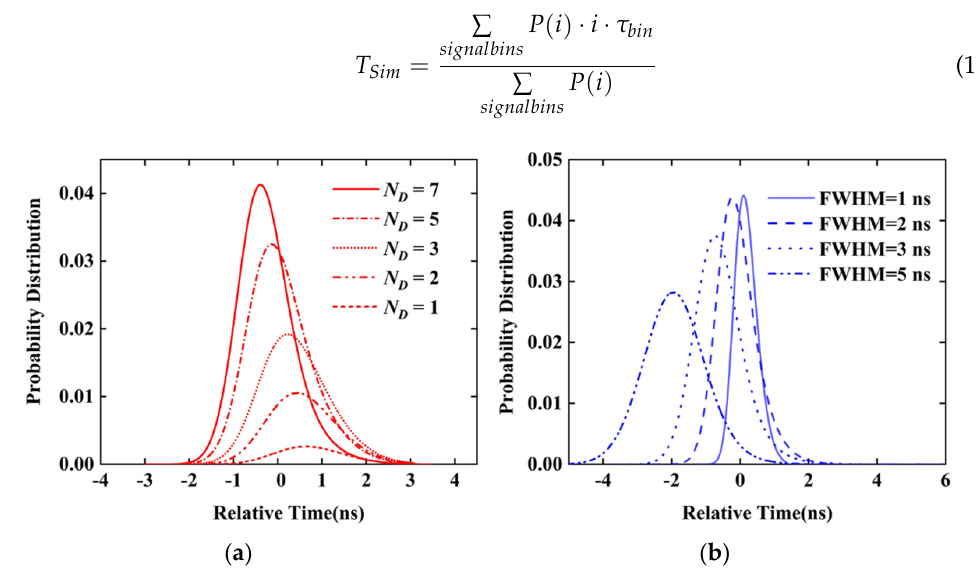
Figure 2. Detection probability under different circumstances: ( a ) echo light intensities and ( b ) FWHM of the laser pulse.